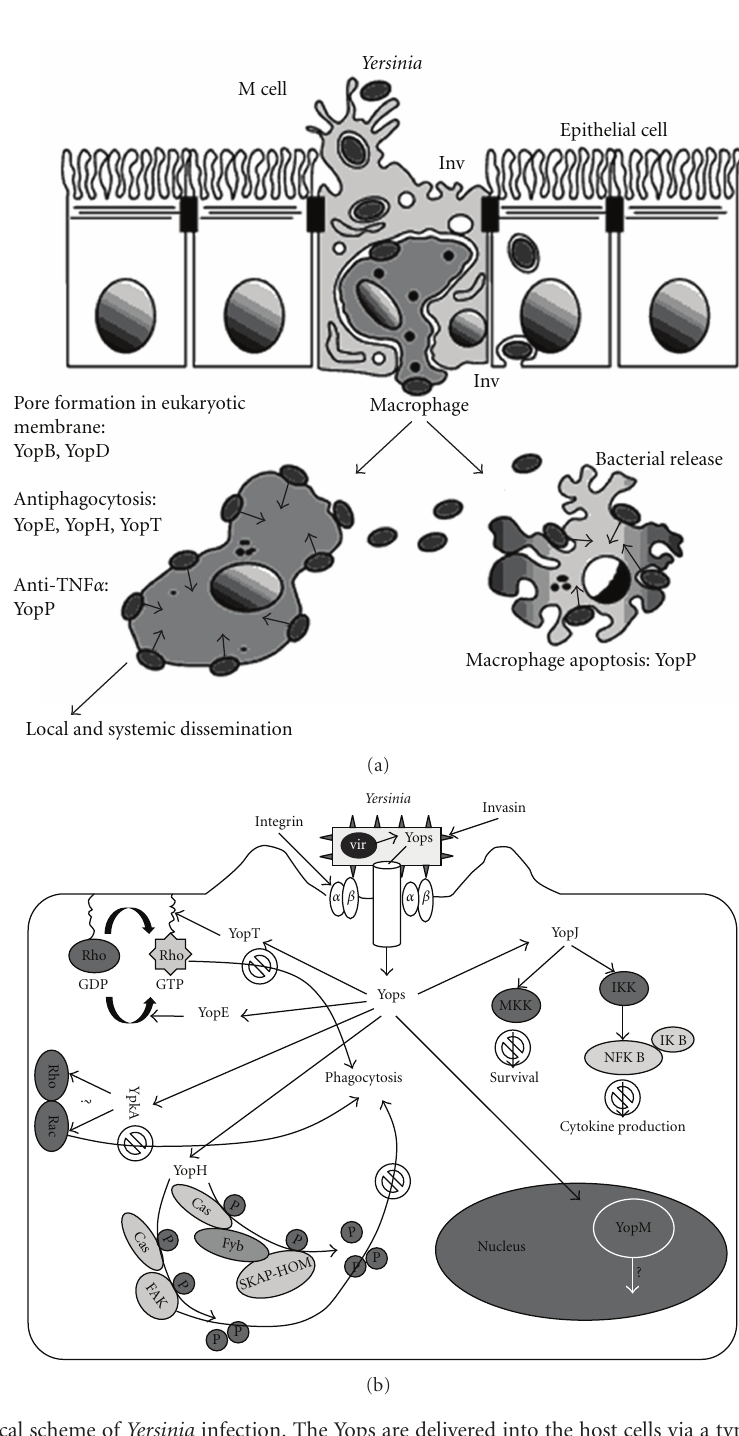
Figure 4: Physiopathological scheme of Yersinia infection. The Yops are delivered into the host cells via a type III secretion system. YopH, a tyrosine phosphatase, dephosphorylates Cas and FAK (protein tyrosine kinase) in epithelial cells, and Cas, Fyb, and SKAP-HOM in macrophages that are involved in the assembly of cytoskeletal complexes required for phagocytosis [78]; YopT modifies the Rho family GTPases by inducing redistribution of the RhoA GTPase [79]; YopE inactivates the Rho family of GTPases involved in phagocytosis [80]; YpkA binds to Rac and Rho (function unknown). These four Yops alter or disrupt the actin cytoskeleton and thereby block phagocytosis. YopJ impairs activation of MAPKKs and NF-B, which induces apoptosis and inhibits cytokine production. YopM is translocated into the nucleus (function unknown; adapted from